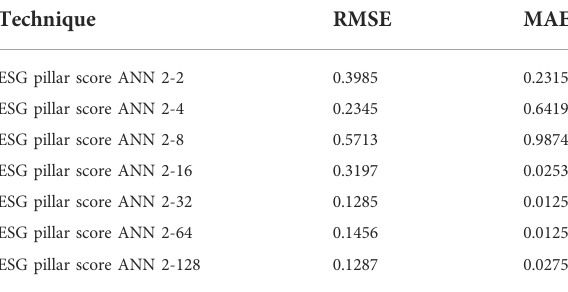
Technique Technique